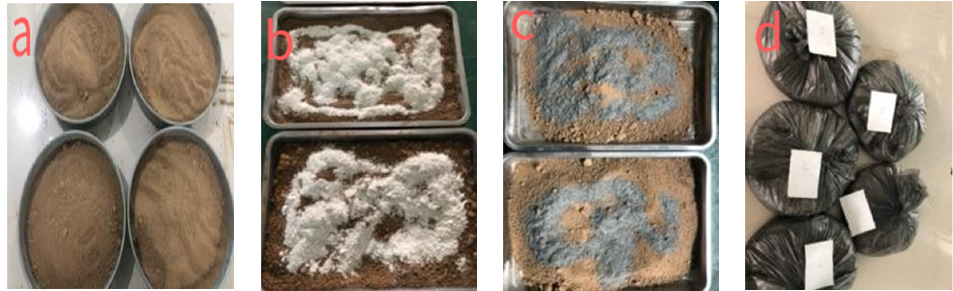
Figure 1. Improvement steps of silt specimen. ( a ) silt screening. ( b ) adding lime. ( c ) adding cement. ( d ) specimen maintenance.